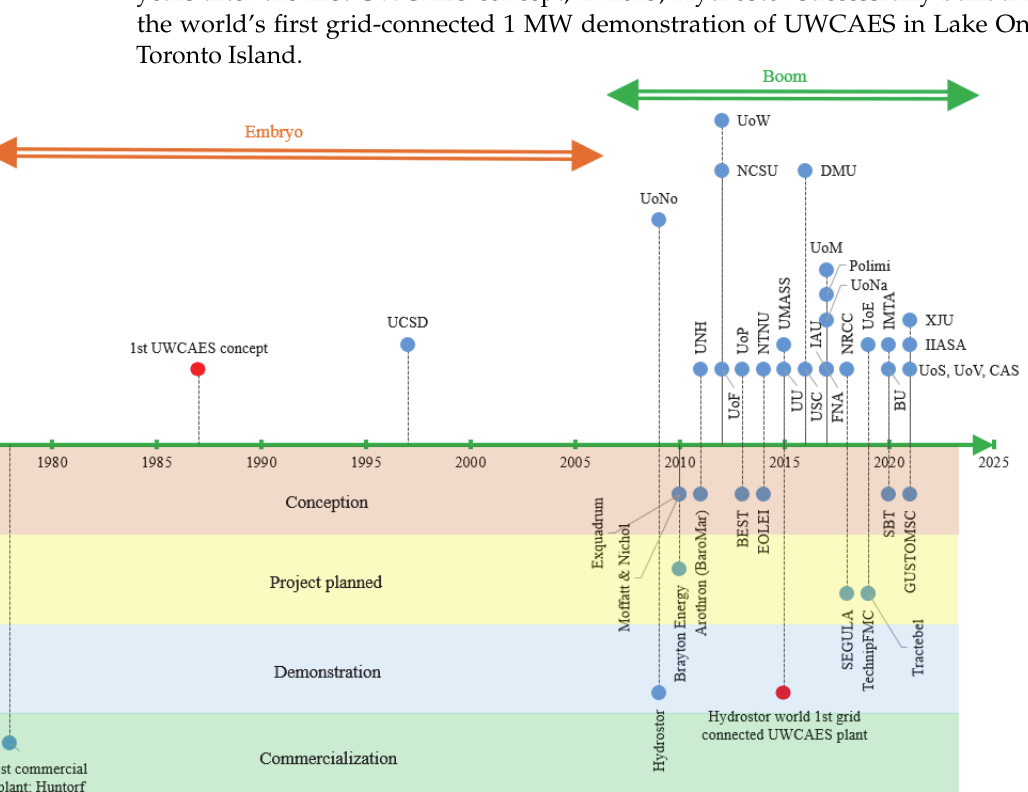
Figure 2. Timeline of major academic and industrial milestones of UWCAES. The point-in-time is confirmed according to the earliest traceable publications or announcements. The data go through June 2020. For the upper academic area, the length of the dotted line is related to the number of publications of various institutes of corresponding authors. For the lower industrial area, the length of the dotted line means the development status of various enterprises. Red points show the most important milestones of UWCAES. Several important underwater hydrogen energy storage cases are also included, such as TechnipFMC, Tractebel, and SBT. (BEST: Bright Energy Storage Technolo-